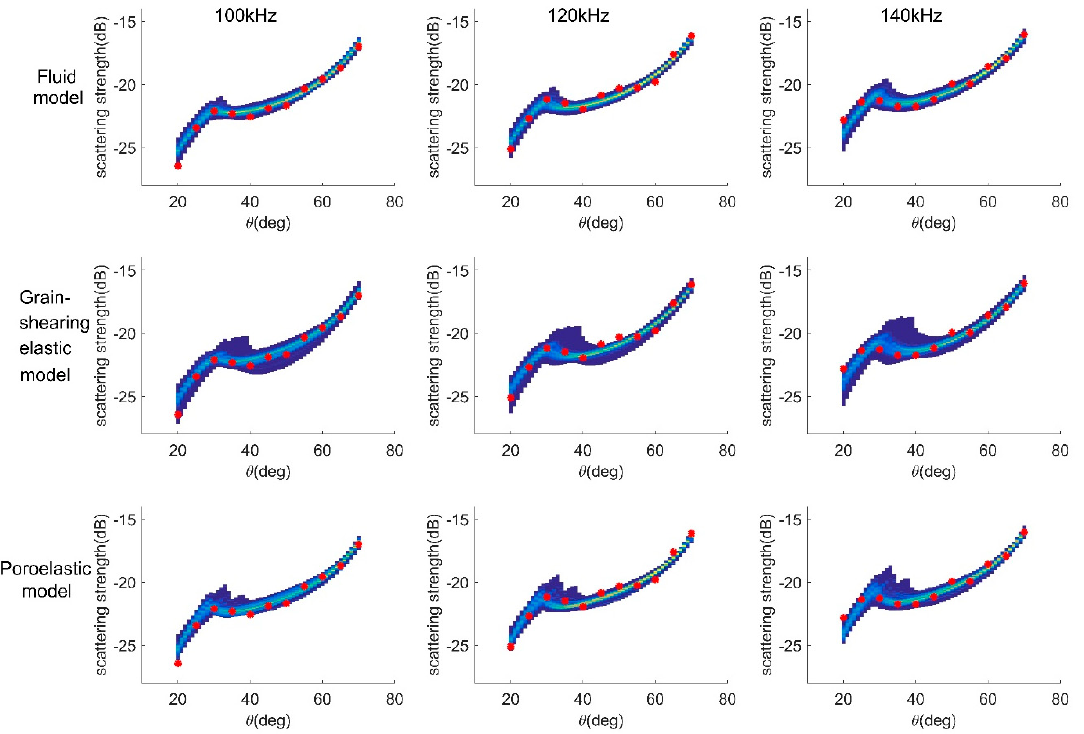
Figure 11. Comparison of uncertainties of backscattering strength predicted by samples based on different models and acoustic frequencies. Red asterisks represent corresponding experimental measurements, as shown in Figure 3.